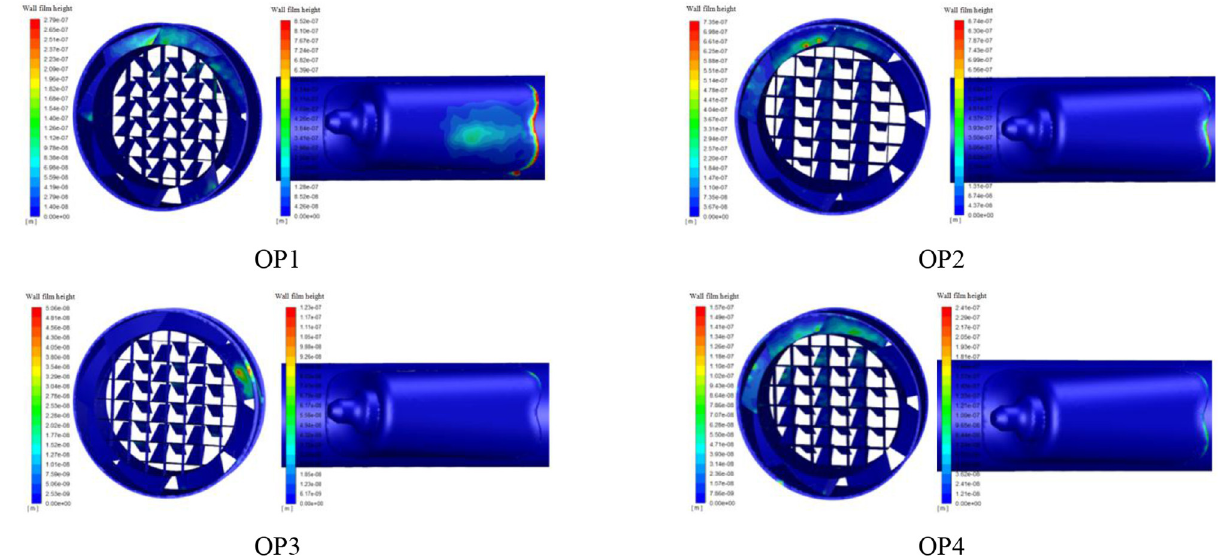
Fig. 13. Distribution of wall fi lm.